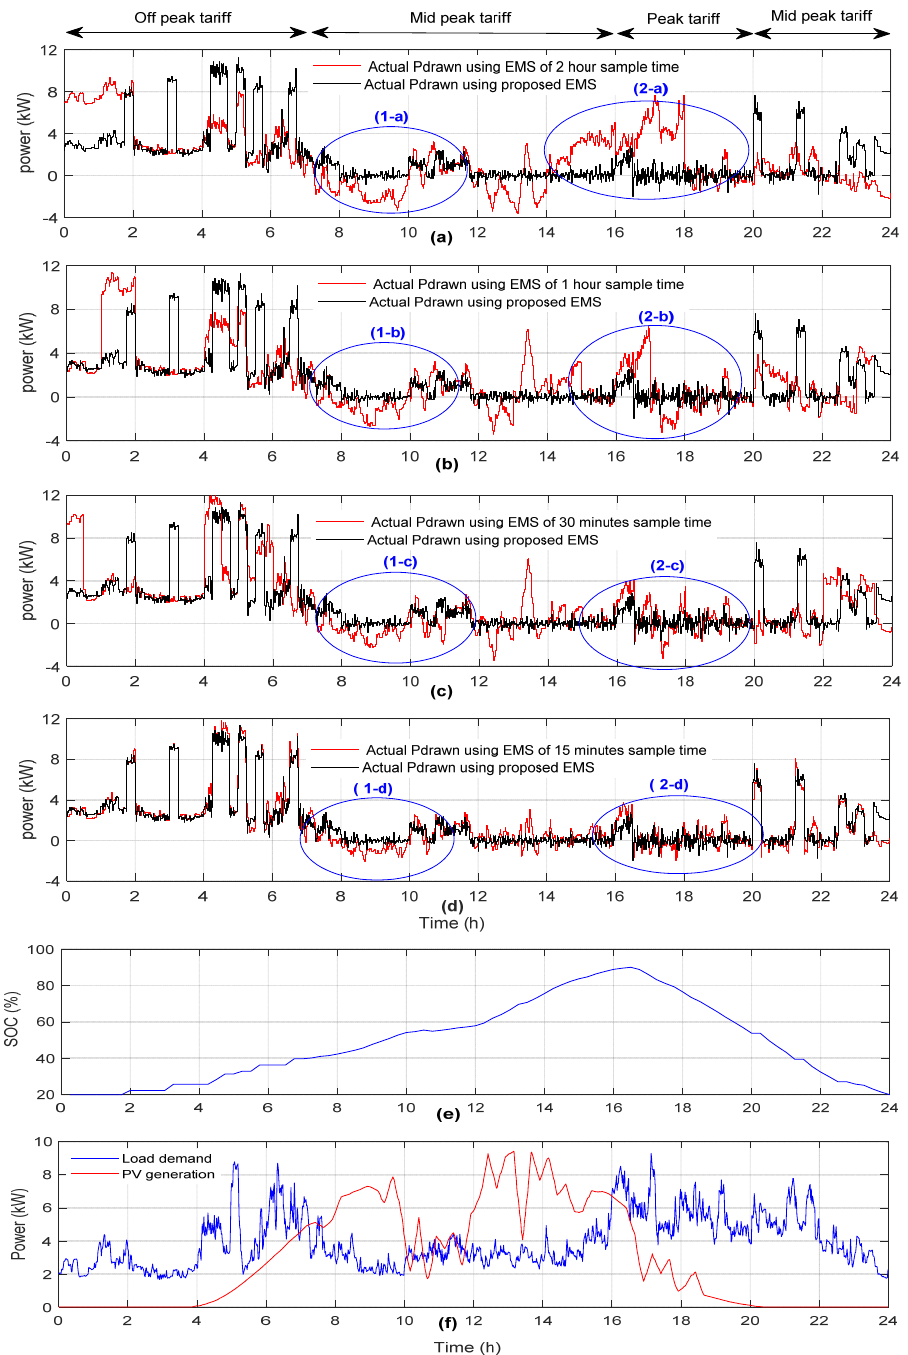
Figure 16. Actual power drawn by the MG from the main electricity grid in case of using the proposed two-layer EMS comparing to: ( a ) Single layer EMS of 2 h sample time; ( b ) Single layer EMS of 1 h sample time; ( c ) Single layer EMS of 30 min sample time; ( d ) Single layer EMS of 15 min sample time; ( e ) The state of charge curve of the BESS; ( f ) Electrical load and PV generation profiles (1 min sample time).